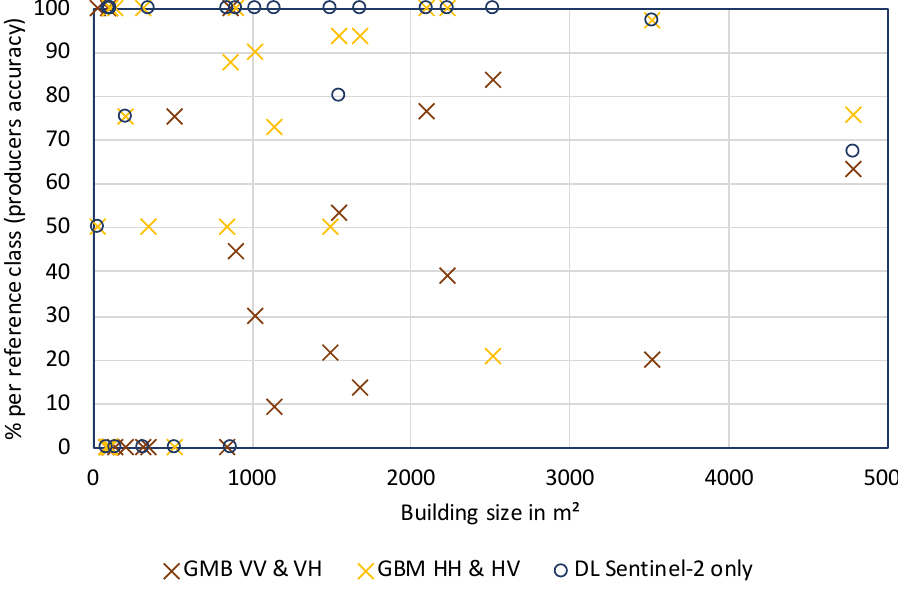
Figure 13. Classification performance results with respect to building size in Longyearbyen, Svalbard (validation data source [54]). DL—Deep Learning, GBM—Gradient Boosting Machines, V—vertical polarization, H—horizontal